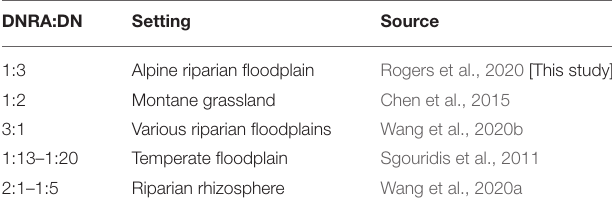
TABLE 4 | Relative contribution of DNRA and DN to total NO − 3 reduction under different